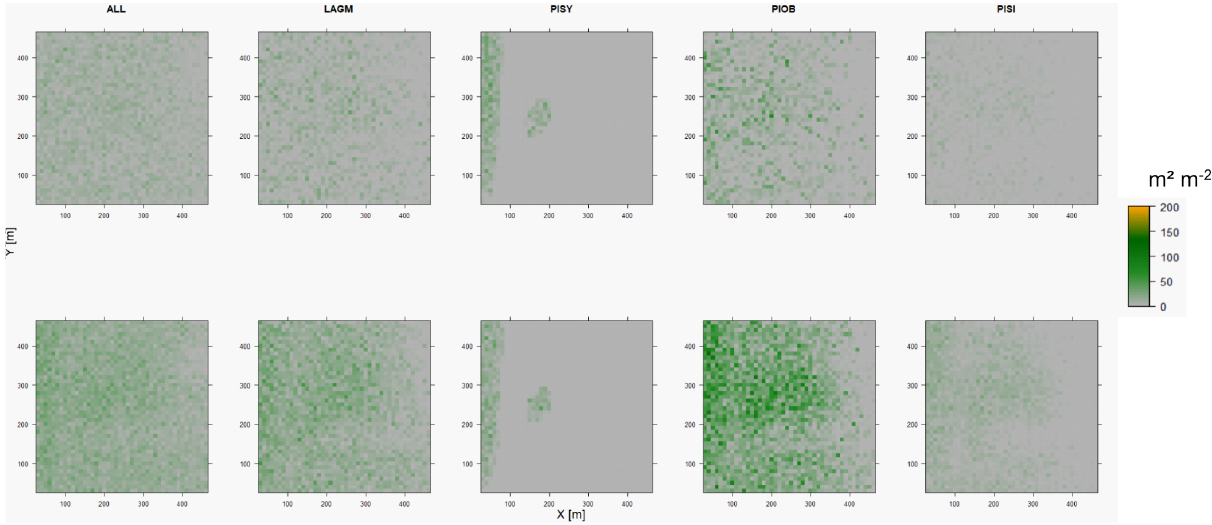
Figure D3. Leaf area index (LAI) values of the CryoGrid grid aggregated at year 2025 at Lake Khamra. Upper row shows LAVESI–CryoGrid coupled; lower row shows LAVESI simulations. LAGM: Larix gmelinii ; PIOB: Picea obovata ; PISI: Pinus sibirica ; PISY: Pinus sylvestris .